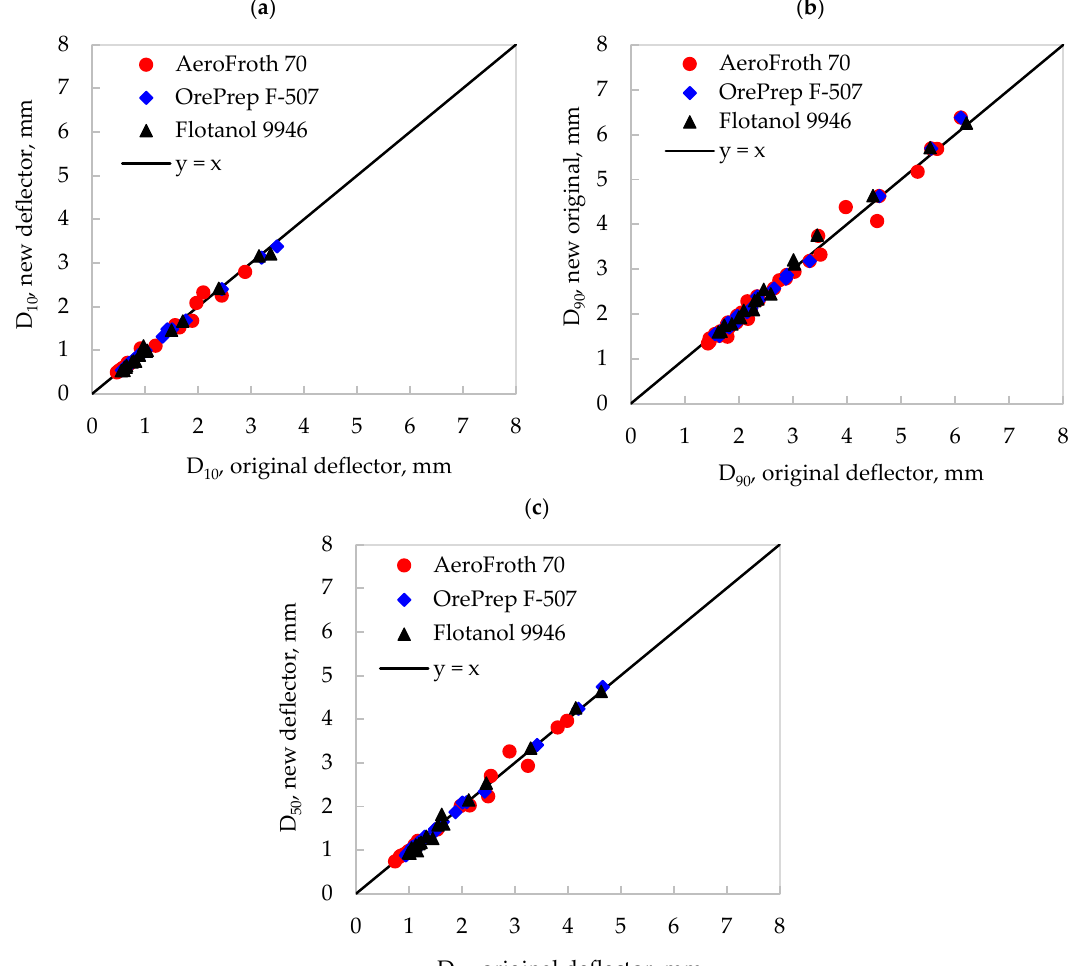
Figure A1. Comparison of different percentiles of the BSDs when using the original and new deflecting systems in the McGill bubble size analyzer: ( a ) 10th percentile (D 10 ), ( b ) 90th percentile (D 90 ) and ( c ) 50th percentile or median (D 50 ).